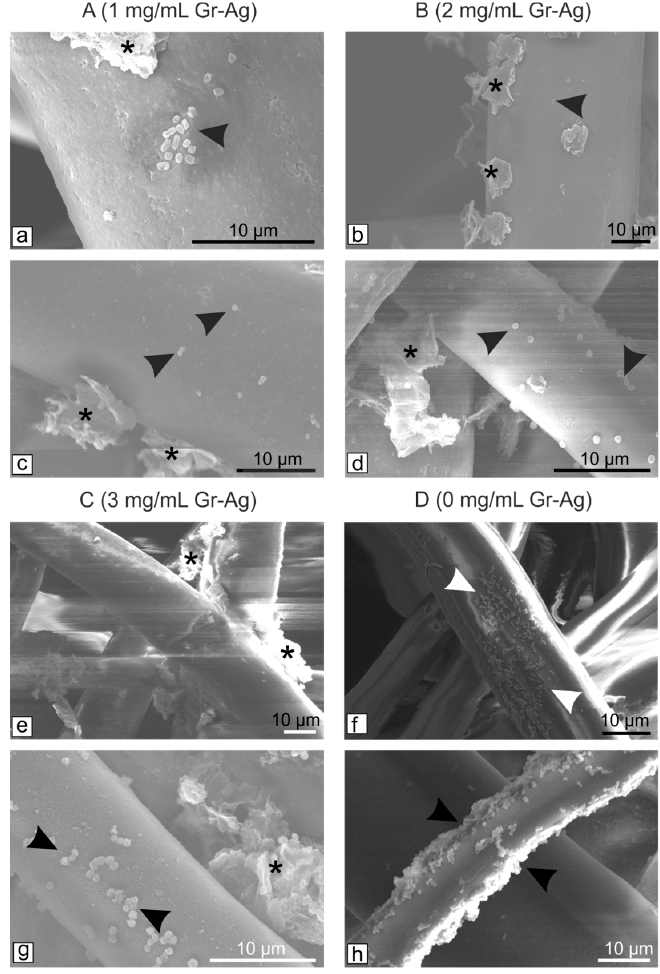
Figure 3. SEM micrographs of the HEPA filters treated with different concentrations of Gr-Ag (5 wt% Ag) hybrid (marked with *) and incubated with bacteria (marked with arrowheads) for 24 h at 37 °C: E. coli ( a , b , e , f ) and S. aureus ( c , d , g , h ). Based on the above measurements, we selected the optimum Gr-Ag (5 wt% Ag) concentration (2 mg/mL) and varied the immersion time: 15 (B 1 ), 30 (B 2 ), 45 (B 3 ) and 60 (B 4 ) min. The Gr-Ag (5 wt% Ag) loading on the HEPA filters was time-dependent, as indicated in Figure 5.